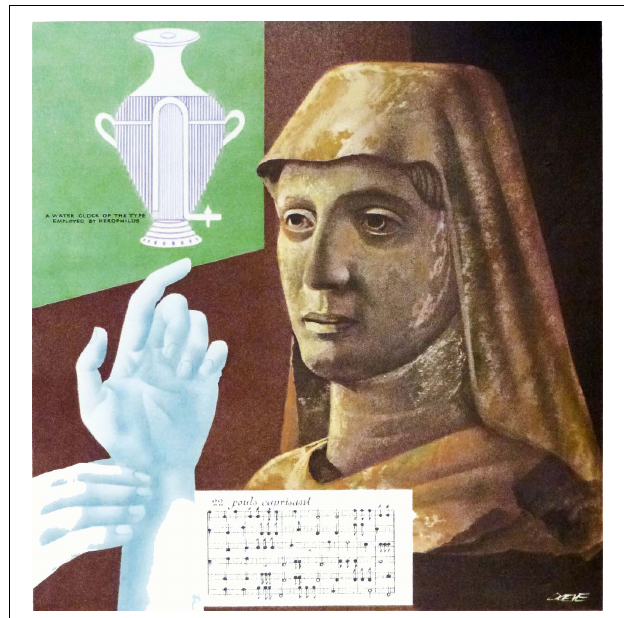
FIGURE 3 | Portrait of Herophilos (ca. 335–280 BC). He was the first to measure the heart beat using a water clock to time the pulse. Source: Reproduced with permission from the John P. McGovern Historical Collections and Research Center; Houston Academy of Medicine-Texas Medical Center Library; Houston,TX, USA. P-254, color photo; Artist: Joseph F. Doeve, painted in